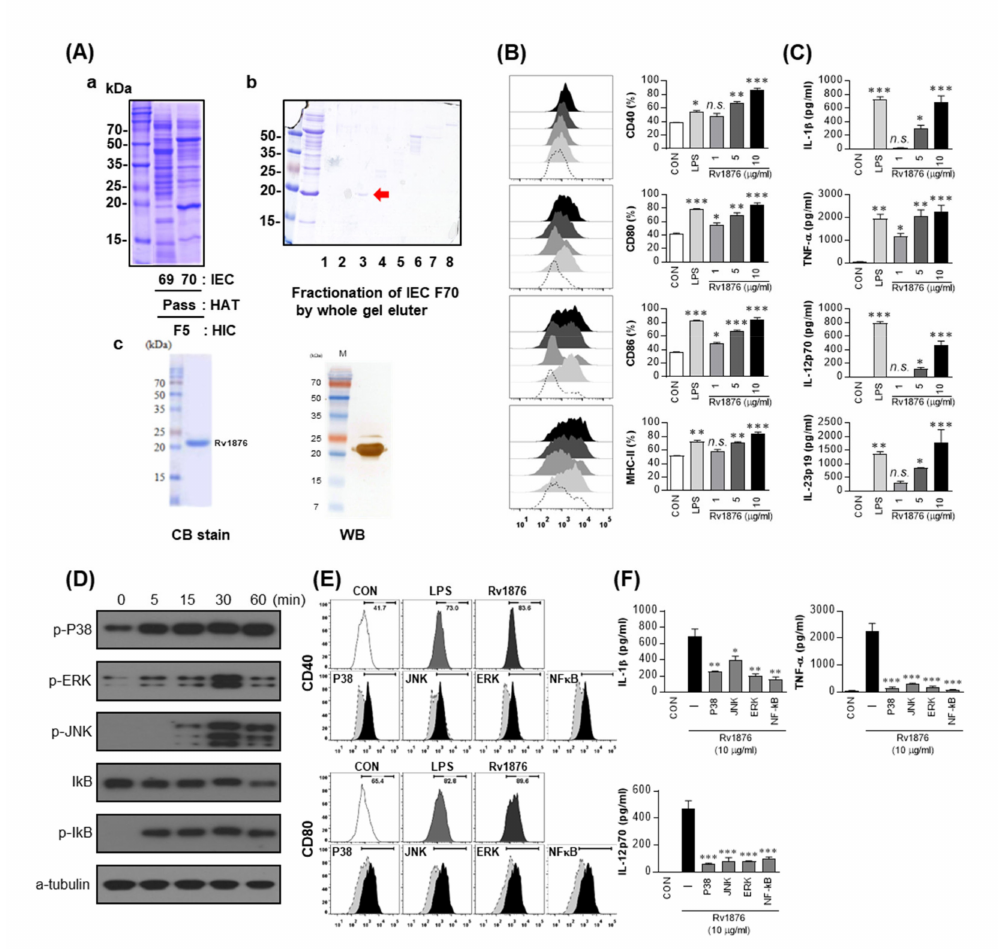
Figure 1. Preparation of Rv1876 and induction of DC maturation by Rv1876. ( A ) ( a ) The 80% ammonium sulfate precipitate of the CFPs was fractionated by hydrophobic interaction chromatography (HIC) using Phenyl Sepharose. The primary fractions were divided and concentrated into seven fractions. Each of the primary fractions was further fractionated using hydroxyapatite chromatography (HAT) using stepwise elution with NaCl. A third fractionation was performed by DEAE ion-exchange chromatography using gradient elution. The eluates were pooled into 80 fractions based on protein band pattern, and were concentrated. ( b ) Finally, the interesting fractions were further fractionated using whole gel eluter. The proteins were analyzed using SDS-PAGE with Coomassie brilliant blue. ( c ) Recombinant Rv1876 produced in BL21